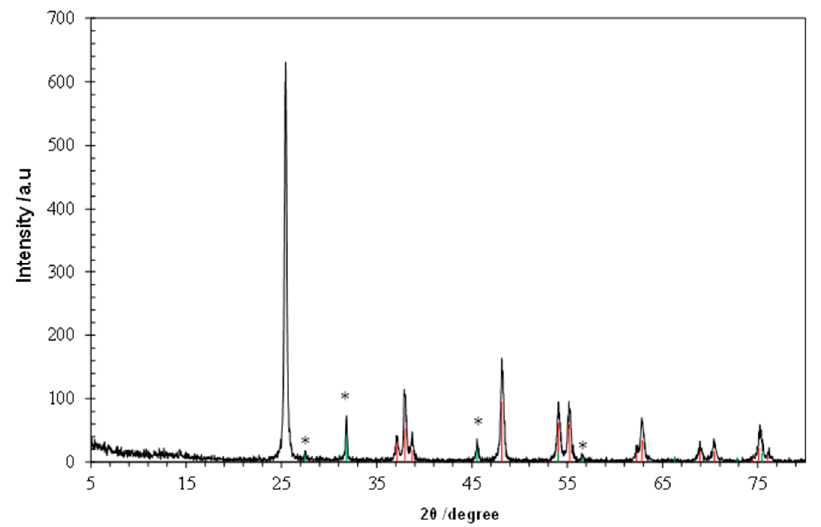
Figure 4. XRD pattern of the generated solid. Maxima noted with an asterisk belong to NaCl.